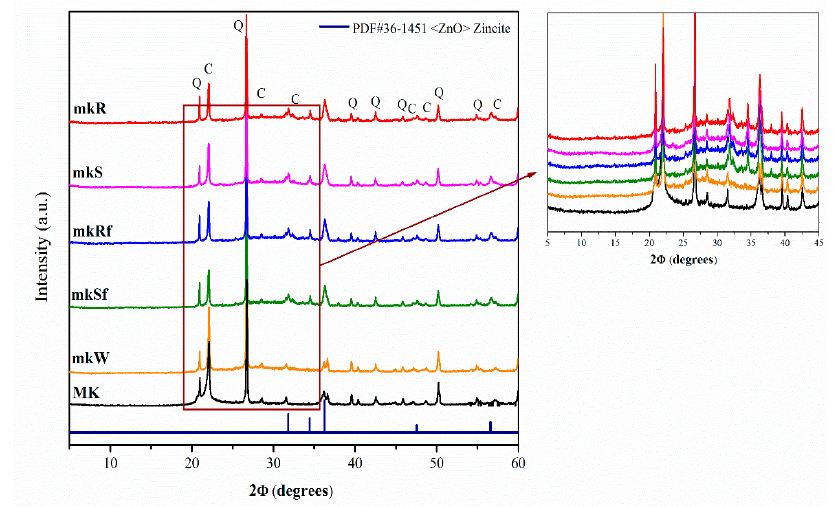
Figure 1. XRD di ff ractograms of metakaolin-based pastes with nanoparticles functionalized and Figure 1. XRD diffractograms of metakaolin-based pastes with nanoparticles functionalized and without without functionalization.